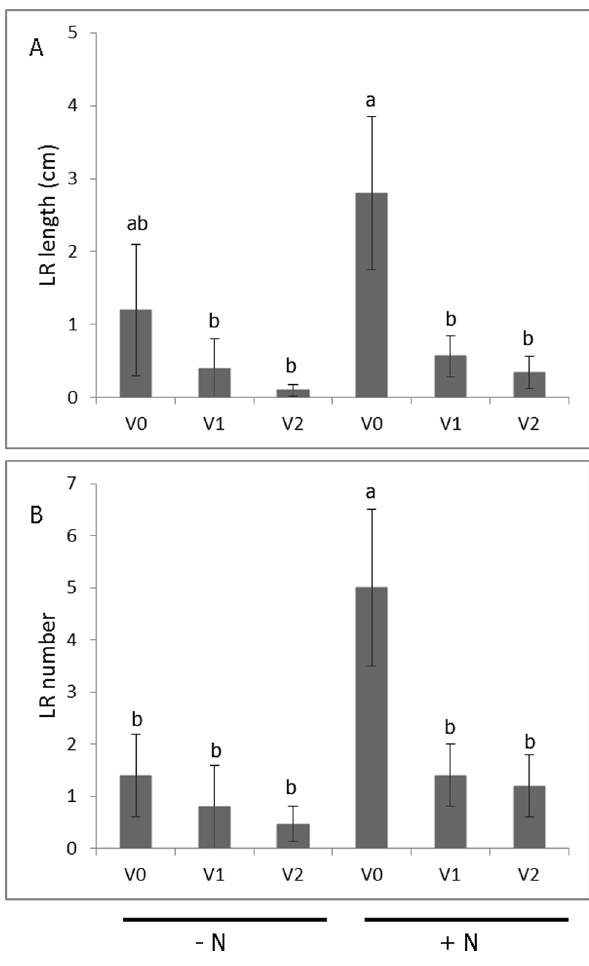
Figure 5. Variation in second order lateral root length (A) and number (B) in response to virus and nitrogen treatments at the onset of storage root initiation in ‘Beauregard’ sweetpotato. Treatment legend: + N = nitrogen provided as KNO 3 , - N=no nitrogen provided. V0 = plants derived from non-inoculated, virus-tested plant stock; V1 = plants derived from V0 plant stock graft inoculated with the potyvirus complex (SPFMV, SPVG, SPVC, and SPV2); V2 = plants derived from plant stock infected with SPCSV. Root length and number were transformed using log 10 and square root transformation, respectively, and Fisher’s LSD test at the 0.05 probability level was used to test for statistical significance. The data are expressed as means 6 SE from non- transformed